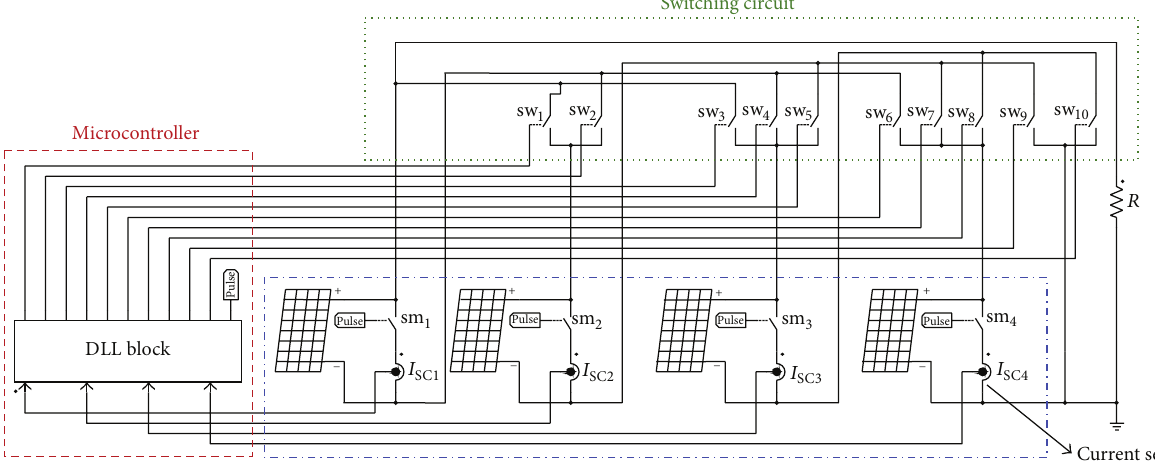
Figure 6: Simplified circuitry of the reconfiguration system for a 2 × 2 matrix.